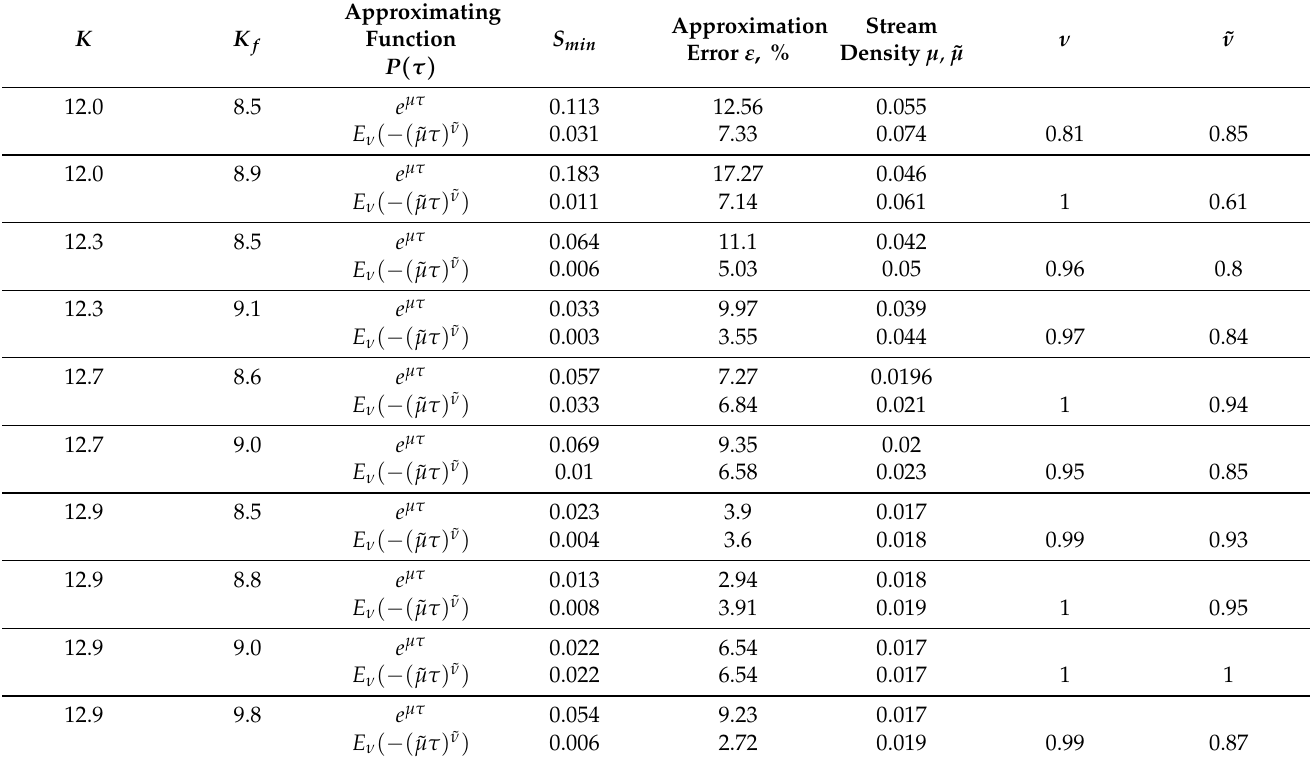
Table 2. Characteristics of approximating